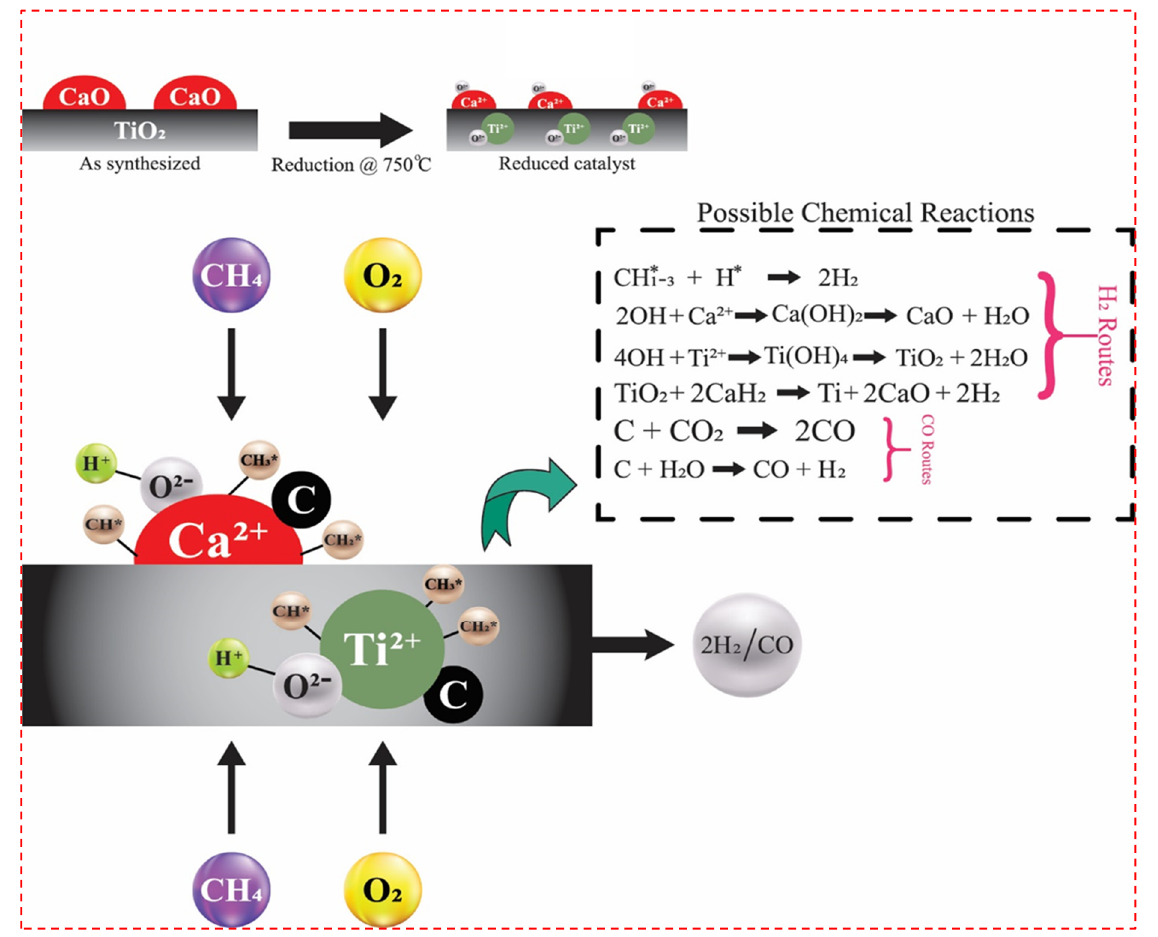
Figure 10. Partial oxidation of CH 4 to syngas over CaO-TiO 2 catalyst via different routes.